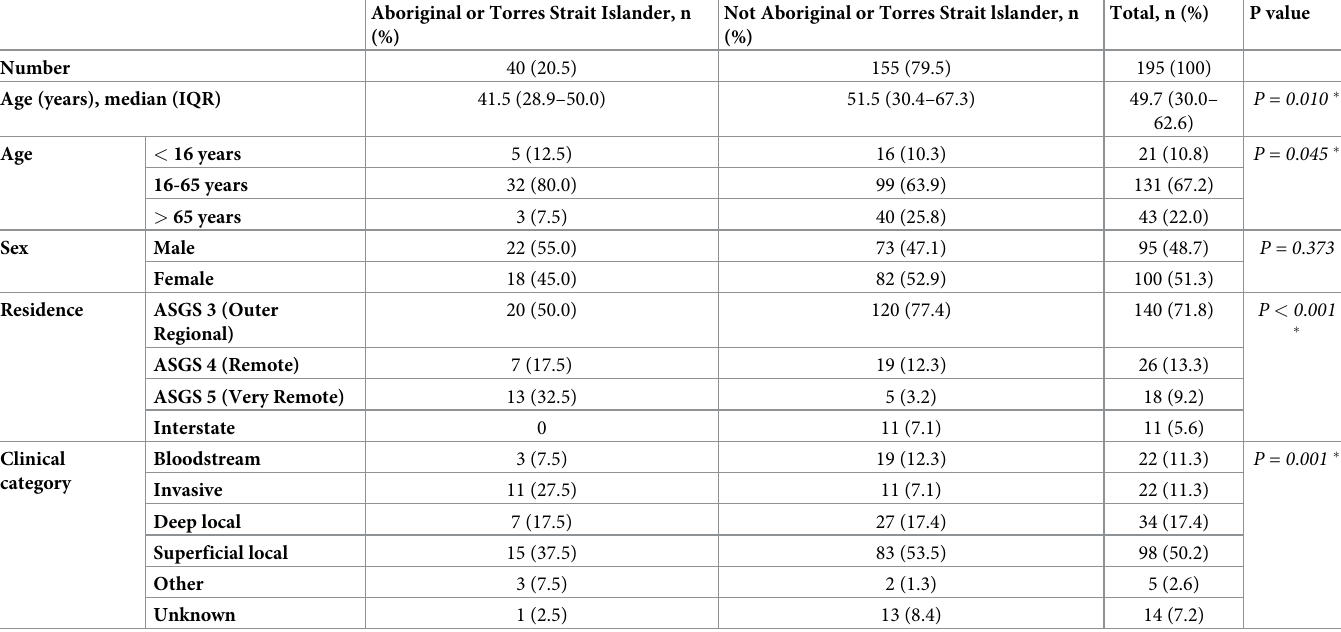
Table 1. Demographics of patients with Pasteurella spp. infections in the Top End from 2000-2021.